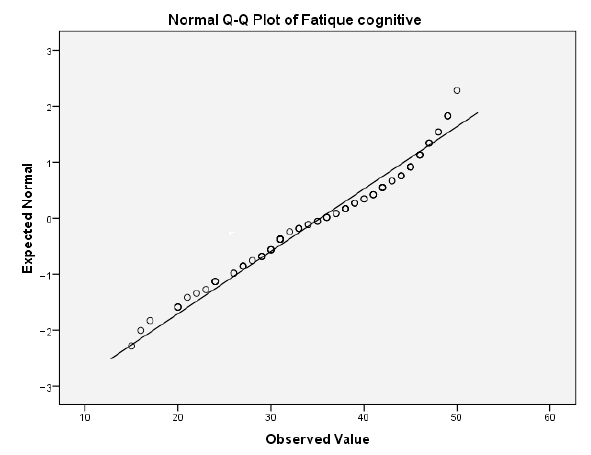
Figure 5. Normal Q-Q plot of cognitive fatigue.